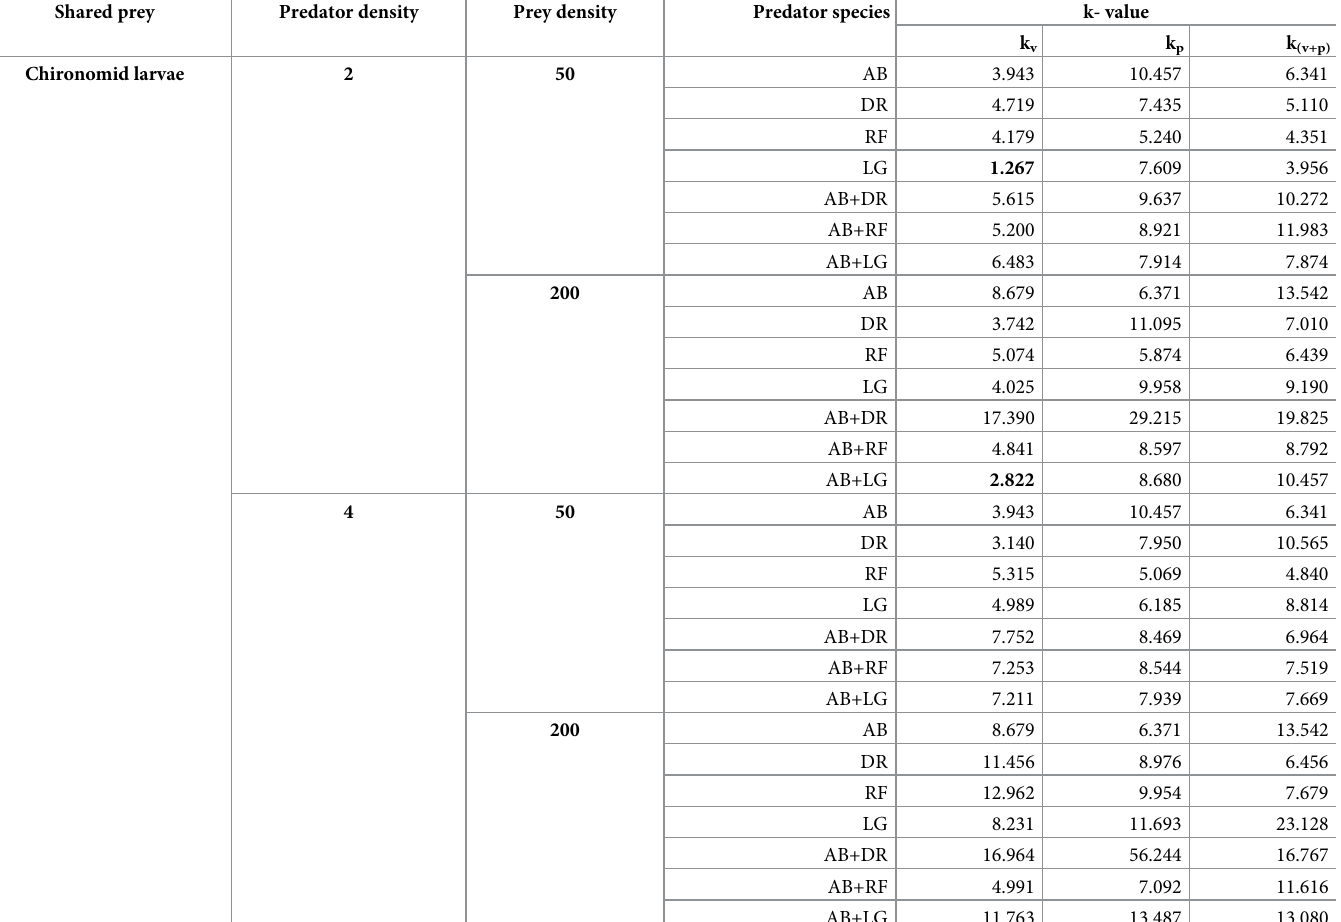
Table 4. Results of the t-test using chironomid larvae as shared prey in the IGP system with different habitat conditions (v–vegetation, p–pebbles and v+p—vegeta- tion and pebbles) against open condition. Shared